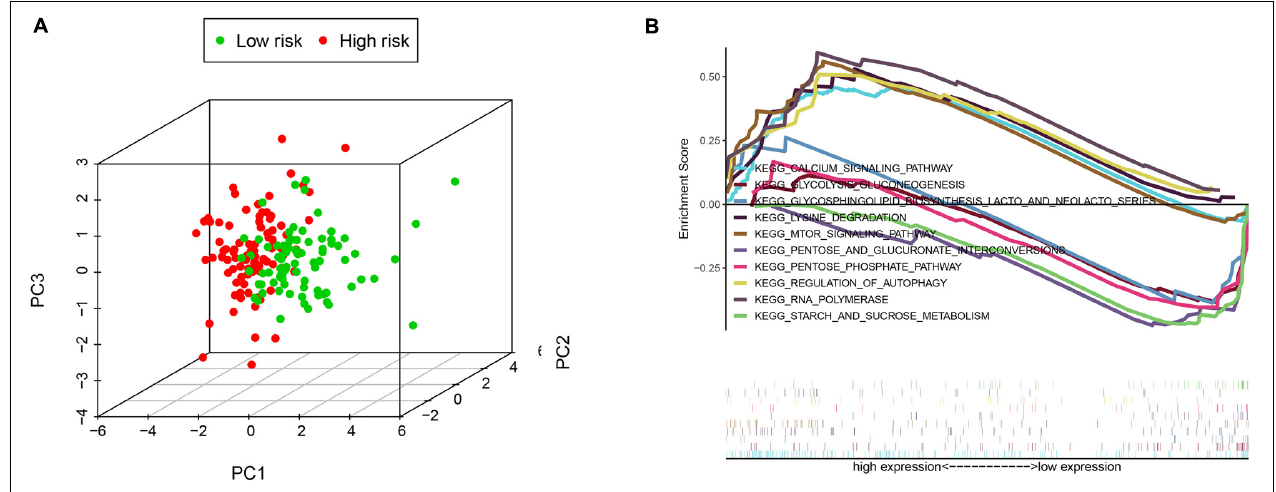
FIGURE 4 | The low-risk and high-risk groups displayed different autophagy statuses. (A) Principal components analysis between low- and high-risk groups on the basis of the autophagy-related gene sets. (B) Gene set enrichment analysis (GSEA) of the two